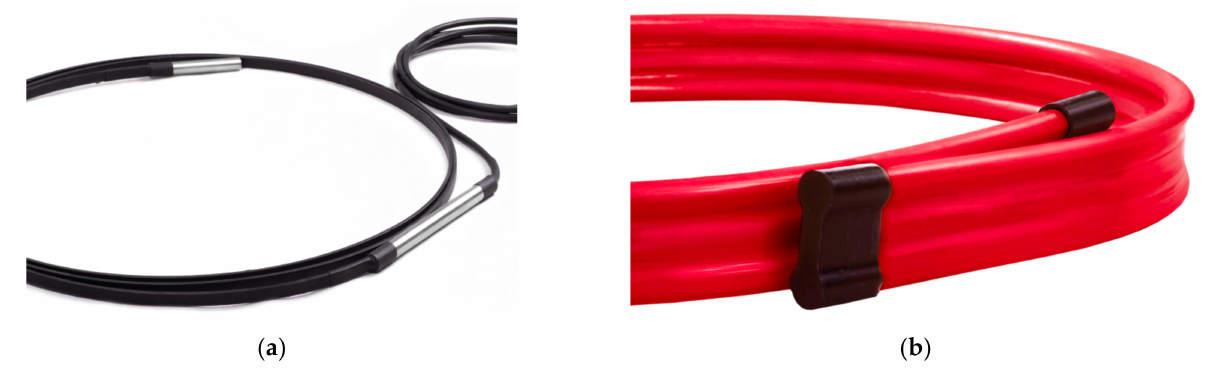
Figure 12. Composite DFOS fibre optic 3DSensor for displacement (shape) monitoring: ( a ) laboratory version; ( b ) in situ version for field